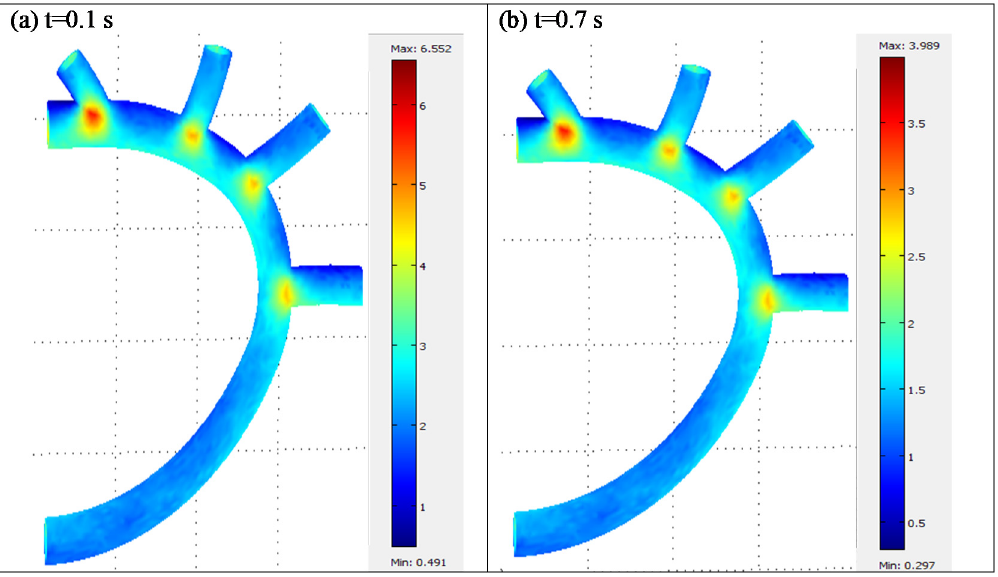
Figure 8. Displacements in the blood vessel using a hyperelastic model; ( a ) t=0.1 s and ( b ) t=0.7 s.